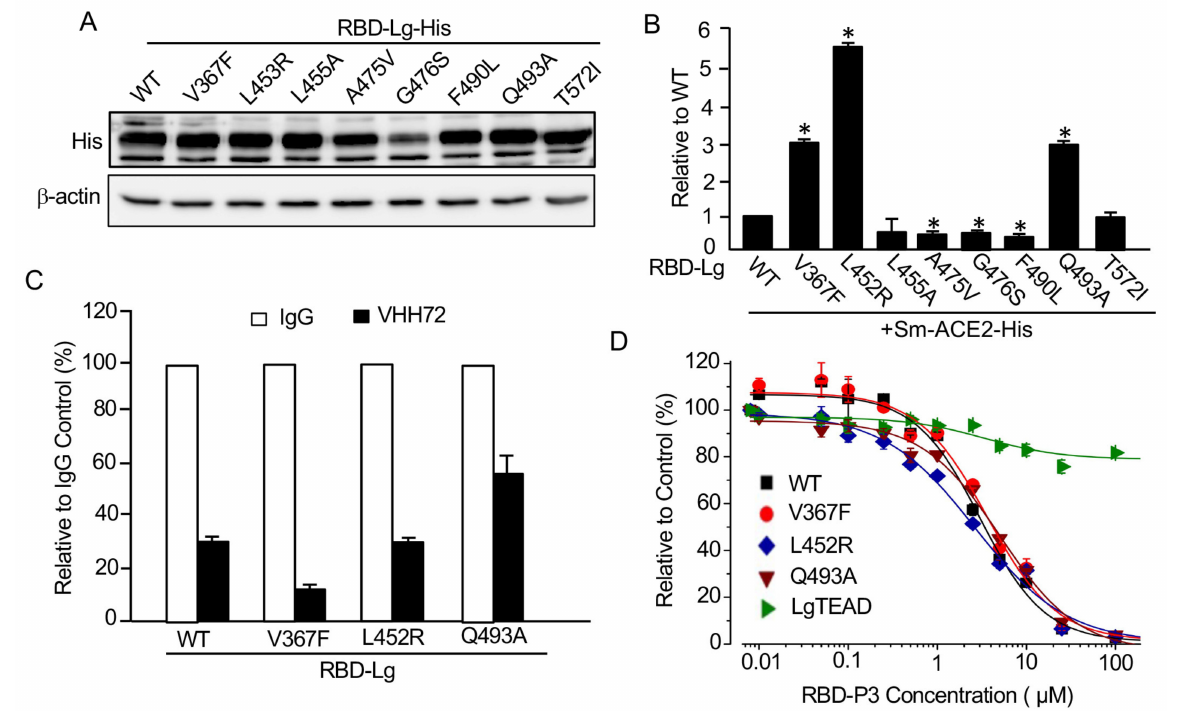
Figure 4. Mutations of SARS-CoV-2 RBD on its interaction with ACE2 and response to antibody and peptides. ( A ) Western blot analysis of wild-type (WT) and mutant RBD-Lg-His. ( B ) Mutations of RBD on its ACE2-binding ability. In vitro luciferase assay was carried out as described in Figure 1E. ( C ) Mutations of RBD on their response to antibody. Protein lysates extracted from WT or mutant RBD-Lg-His were preincubated with 50 µ g/mL of IgG or VHH72, and subsequently incubated with Sm-ACE2 lysate, followed by luciferase assay. ( D ) Mutations of RBD on their response to peptide inhibition. Experimental procedures and data analysis are as described in Figure 3D. *, p <